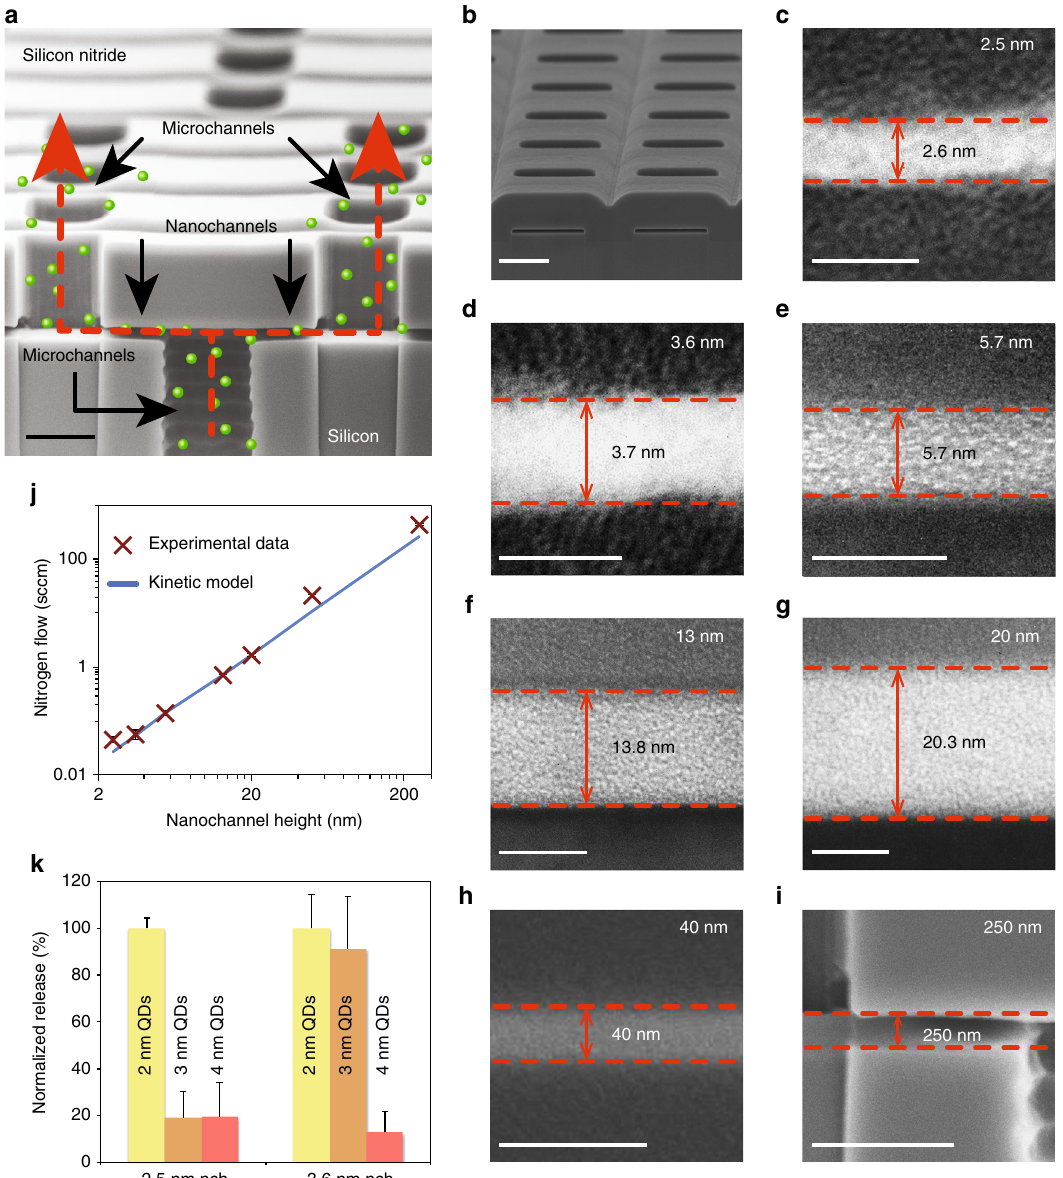
Fig. 1 Characterization of the nanochannel membranes used in this study. a SEM cross-section of the silicon membrane structure illustrating the molecular pathway through the channels (the particles in green represent molecules not to scale). The inlet and outlet microchannels present a width of 3 µ m, a height of 1 µ m, and a respective length of 15 and 1.7 µ m. The nanochannels present a width of 3 µ m, a length of 1 µ m, and height of 2.5 – 250 nm. Scale bar: 1 µ m. b Lateral view SEM image of a sectioned nanochannel membrane. Scale bar: 2 µ m. c – h TEM images of 2.5 to 40 nm nanochannel cross-sections. Scale bars: 5 nm ( c , d ), 10 nm ( e – g ), and 100 nm ( h ). i SEM image of 250 nm nanochannel cross-section. Scale bar: 1 µ m. j Gas testing results of transmembrane nitrogen (N 2 ) fl ow (symbols) showed strong correlation to kinetic model predictions (solid line). These analyses allow for the evaluation of the entire nanochannel population, as opposed to single-channel assessment through SEM/TEM. Error bars are within the marker size for experimental data and the nanochannel sizes maintained a maximum percentage standard deviation of 15%. k Selective fi ltering of 2, 3, and 4 nm (±0.5 nm) neutral quantum dots (QDs) by 2.5 and 3.6 nm nanochannels (nch). Data exhibited tight size selectivity with a resolution of 0.5 nm. Release is normalized to the fl uorescence intensity of the 2 nm QDs. Each of the data for both j and k denotes the average of three individual replicates, error bars are